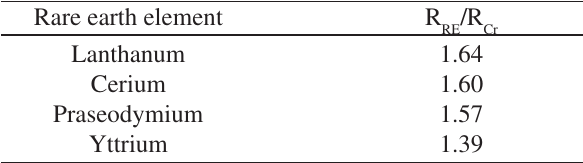
Table 1. Ratio of ionic radii of RE element and